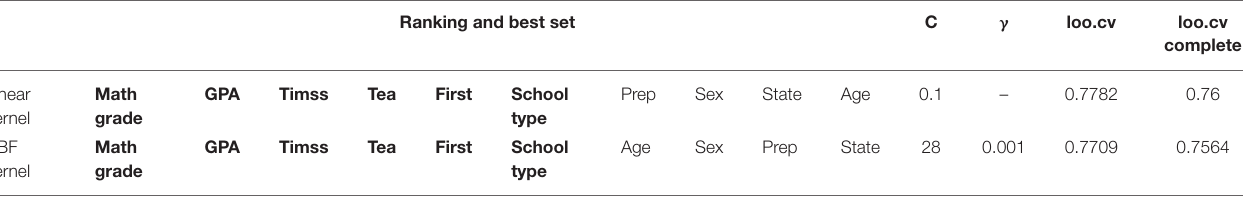
TABLE 4 | Linear and generalized SVM-RFE for linear and RBF kernel: ranking and selected subsets for dataC. Ranking and best set